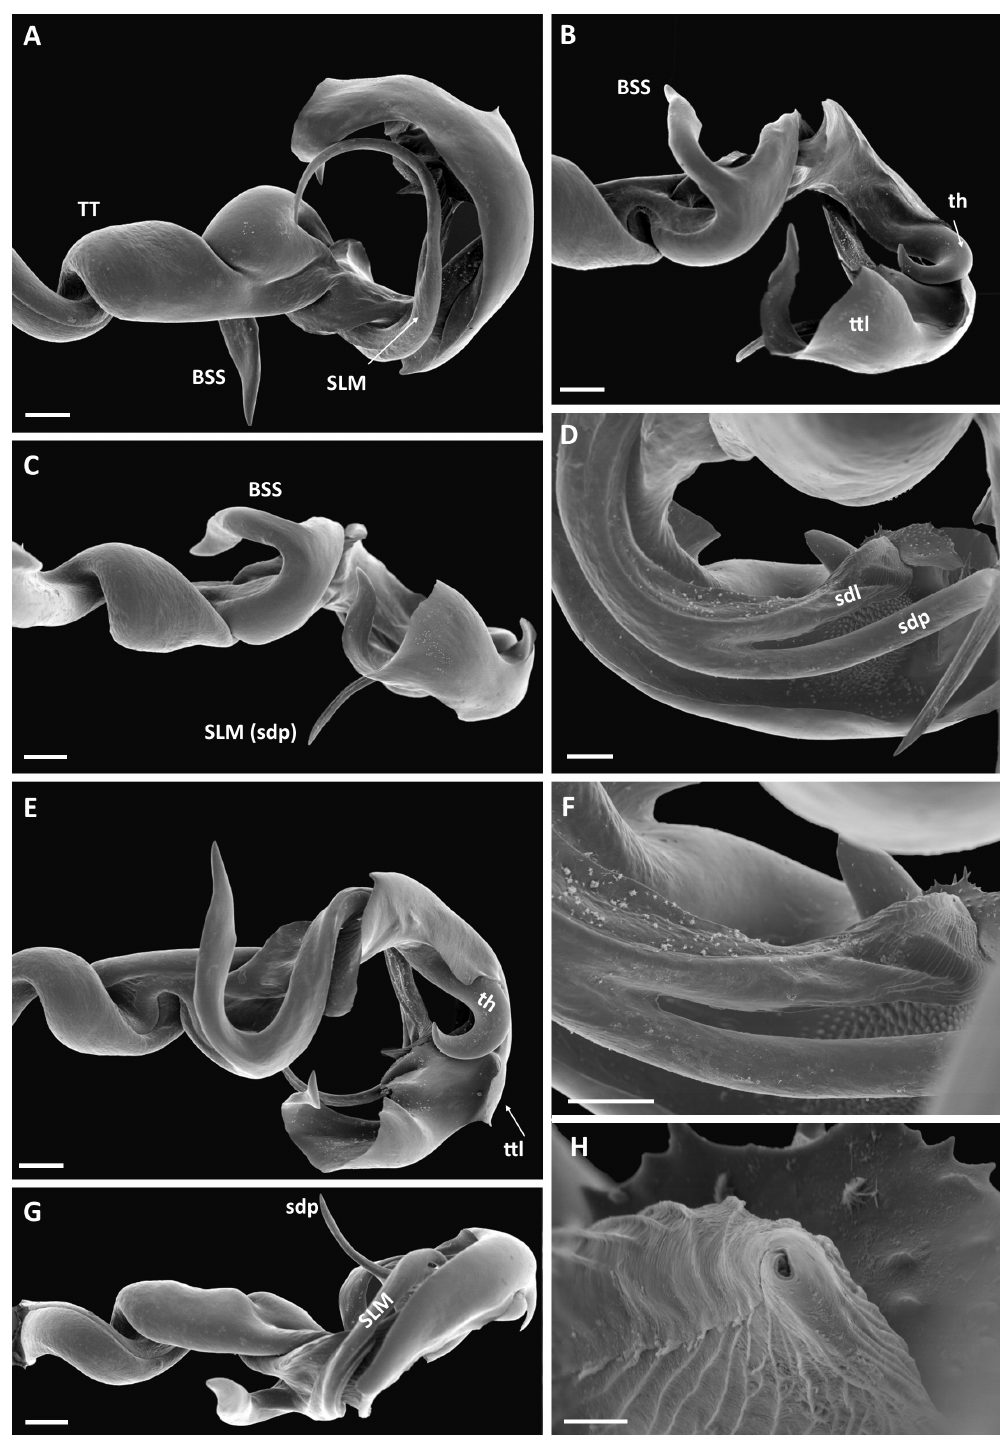
Fig. 68. Xystopyge doggartae sp. nov., holotype, ♂ (NHMD 621768), left gonopod telopodite. A . Anterior view. B . Posterio-lateral view. C . Dorsal view. D, F . Distal part of solenomere resting in telomere gutter. E . Posterior view. G . Ventral view. H . Close-up of opening of efferent canal. Abbreviations: BSS = basal solenomeral spine; sdl = solenomeral distal microstriate branch; sdp = solenomeral distal spinelike branch; SLM = solenomere; th = telomeral hook; TT = torsotope; ttl = telomeral triangular lamella. Scale bars: A–C, E, G = 0.1 mm; D, F = 0.05 mm; H = 0.01